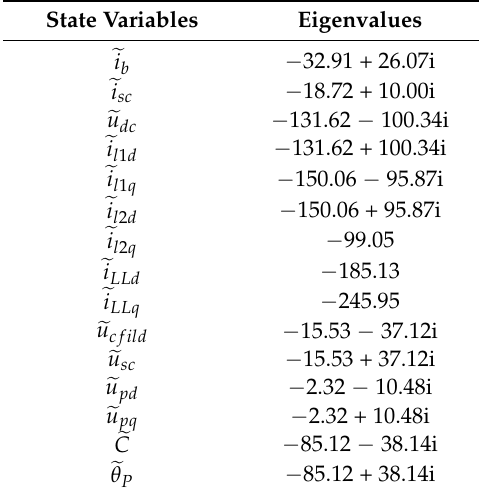
Table 5. Eigenvalues of micro-grid’s state matrix for optimal values of micro-grid parameters. State Variables